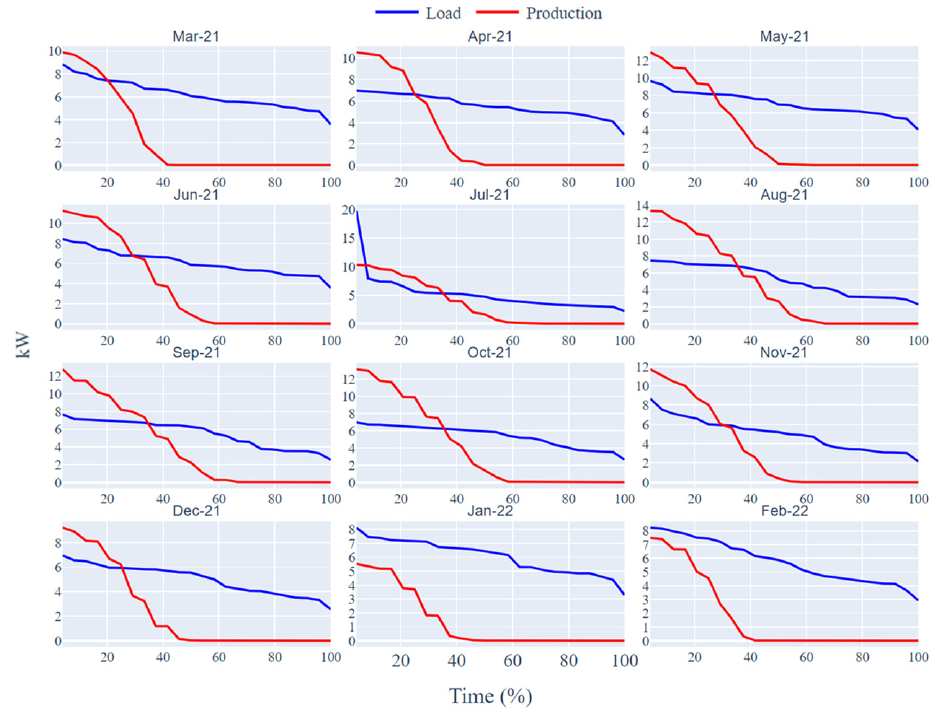
Figure 8. Monthly average duration curves for the period in consideration—computed on average data.